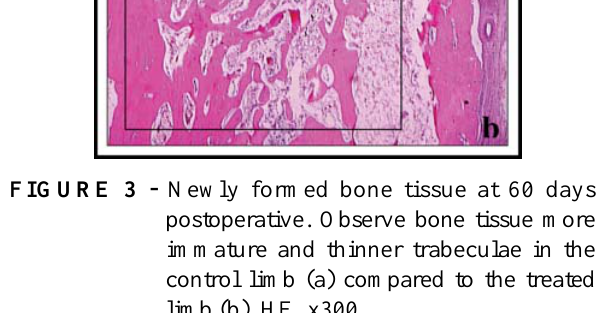
FIGURE 4 - Fracture site of the treated (a) and control (b) forelimb at 90 days postoperative. Observe the decrease of bone callous, repair of cortical (large arrows) and medullary canal (asterisk).